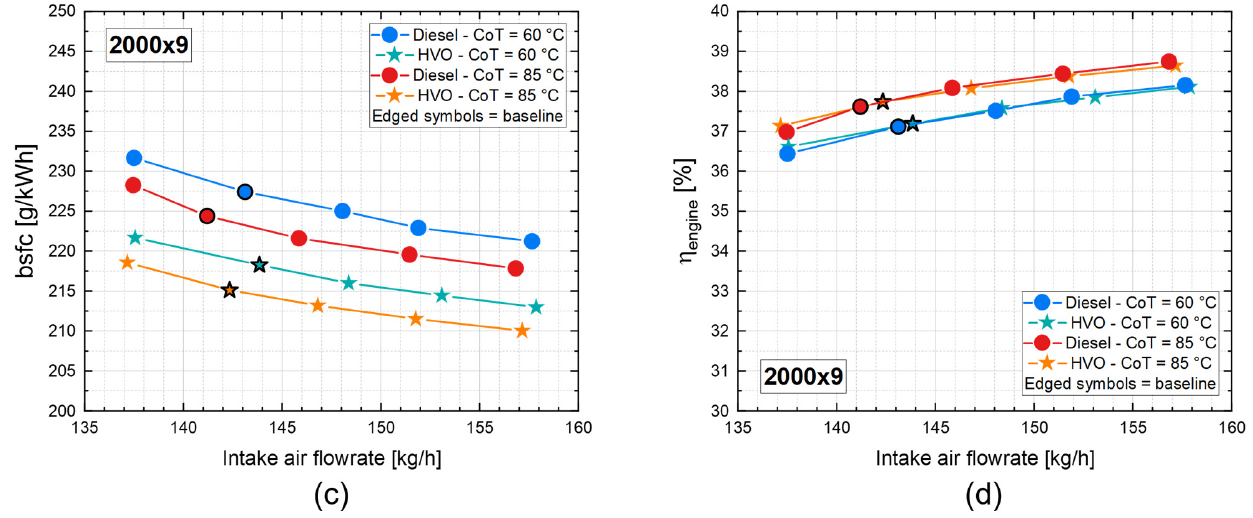
Figure 17. bsfc and engine efficiency along intake air quantity sweep tests at 1250 × 2 ( a , b ) and 2000 × 9 ( c , d ). Comparison between diesel and HVO at high and low coolant temperatures. Warm colors represent high coolant temperatures, while cool colors represent low coolant temperatures. Circles represent diesel, while stars represent HVO.